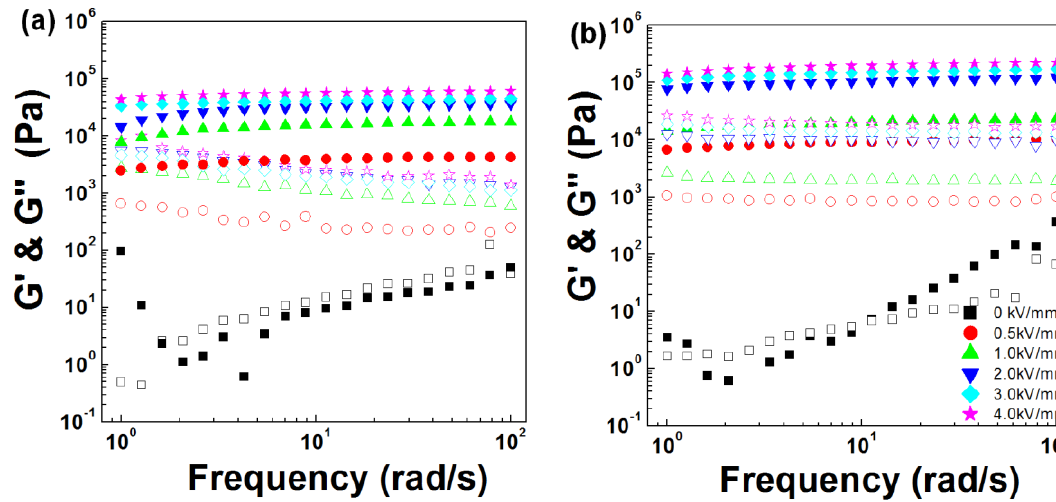
Figure 5. Frequency sweep of the ER fluids at different electric field strengths: ( a ) pristine cellulose; ( b ) urea-terminated silane-modified cellulose (G ′ : closed symbol; G ″ : open symbol).